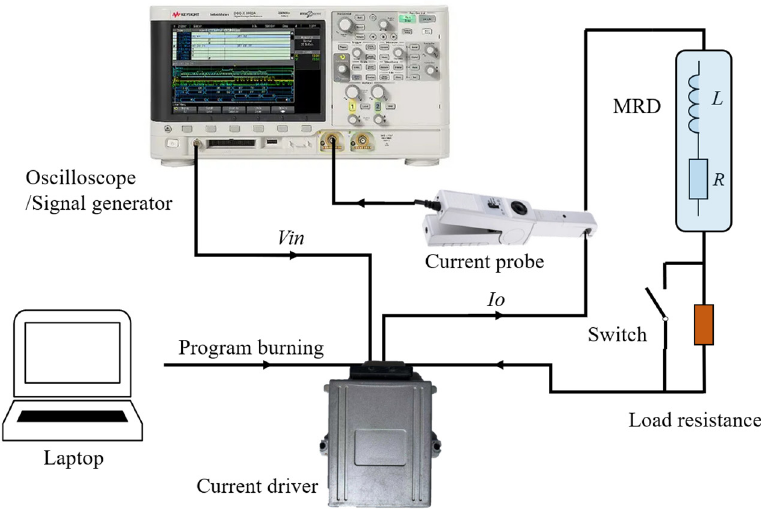
Figure 13. Current driver test connection block diagram.